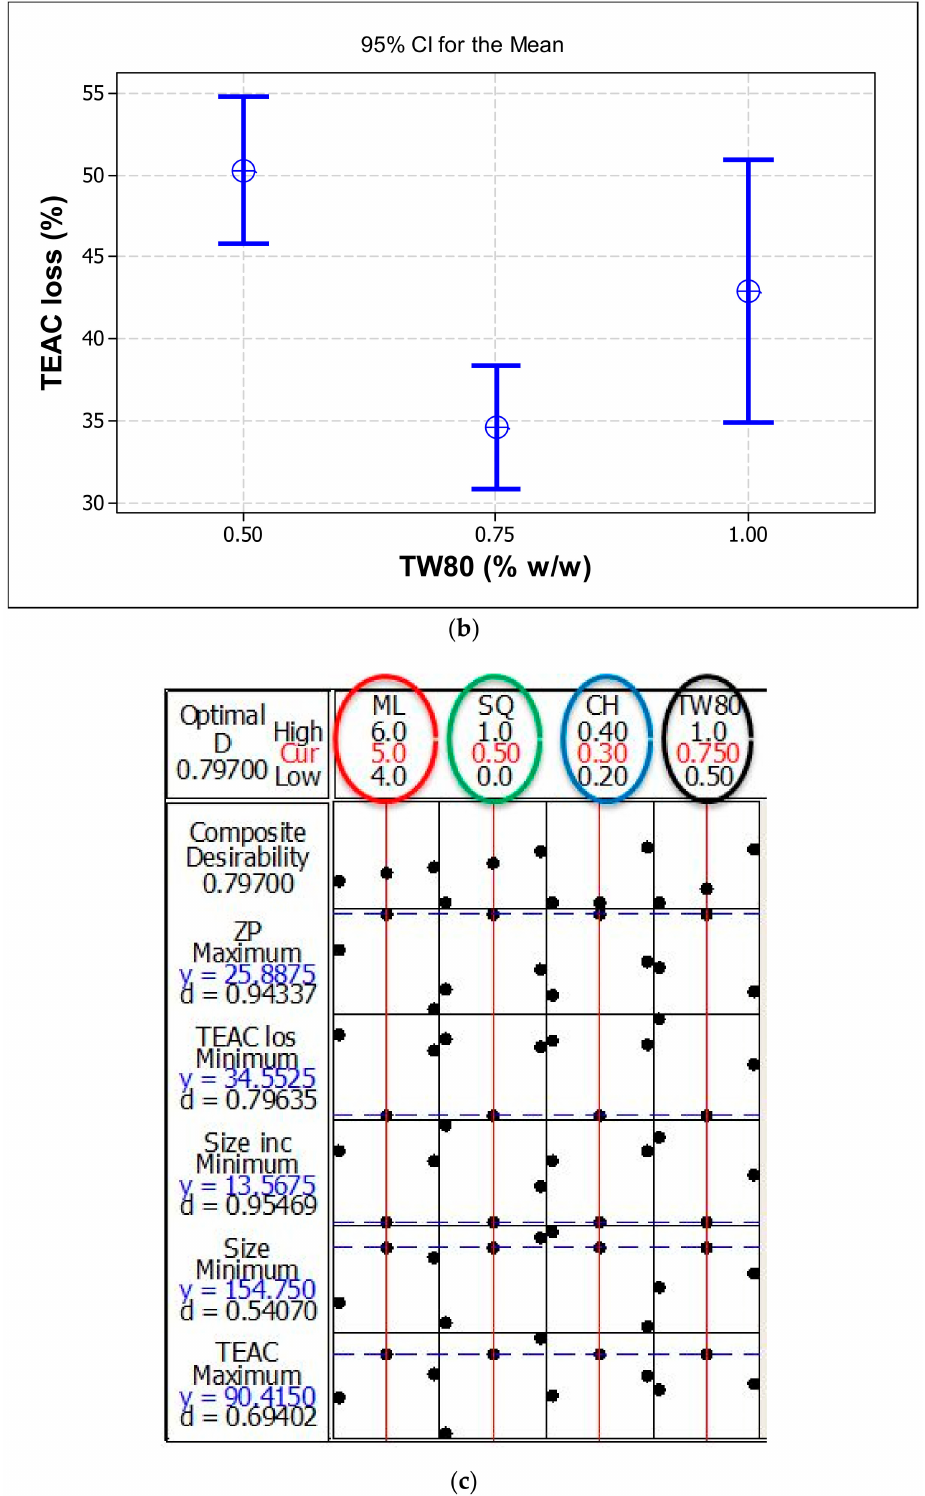
Figure 2. Trolox equivalent antioxidant capacity (TEAC) loss (%) of the prepared liposomes against UV light (280–320 nm, 6 h) a ff ected by the ( a ) combined e ff ects of mixed soy lecithin (ML) and squalene (SQ) concentrations and ( b ) e ff ect of Tween80 (TW80) concentration, and ( c ) multiple response optimizer showing the optimum concentrations of (5% ( w / w ) mixed soy lecithin (ML), 0.5% ( w / w ) squalene (SQ), 0.3% ( w / w ) cholesterol (CH) and 0.75% ( w / w ) Tween80 (TW80)) in order to achieve the maximum zeta potential (ZP) and trolox equivalent antioxidant capacity (TEAC), minimum particle size and loss of TEAC, and minimum increase in